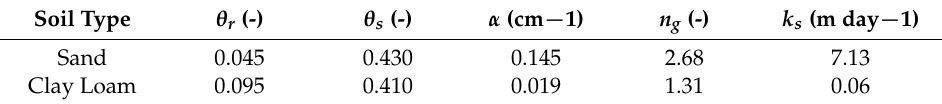
Table 1. Parameters of the van Genuchten hydraulic model for each type of